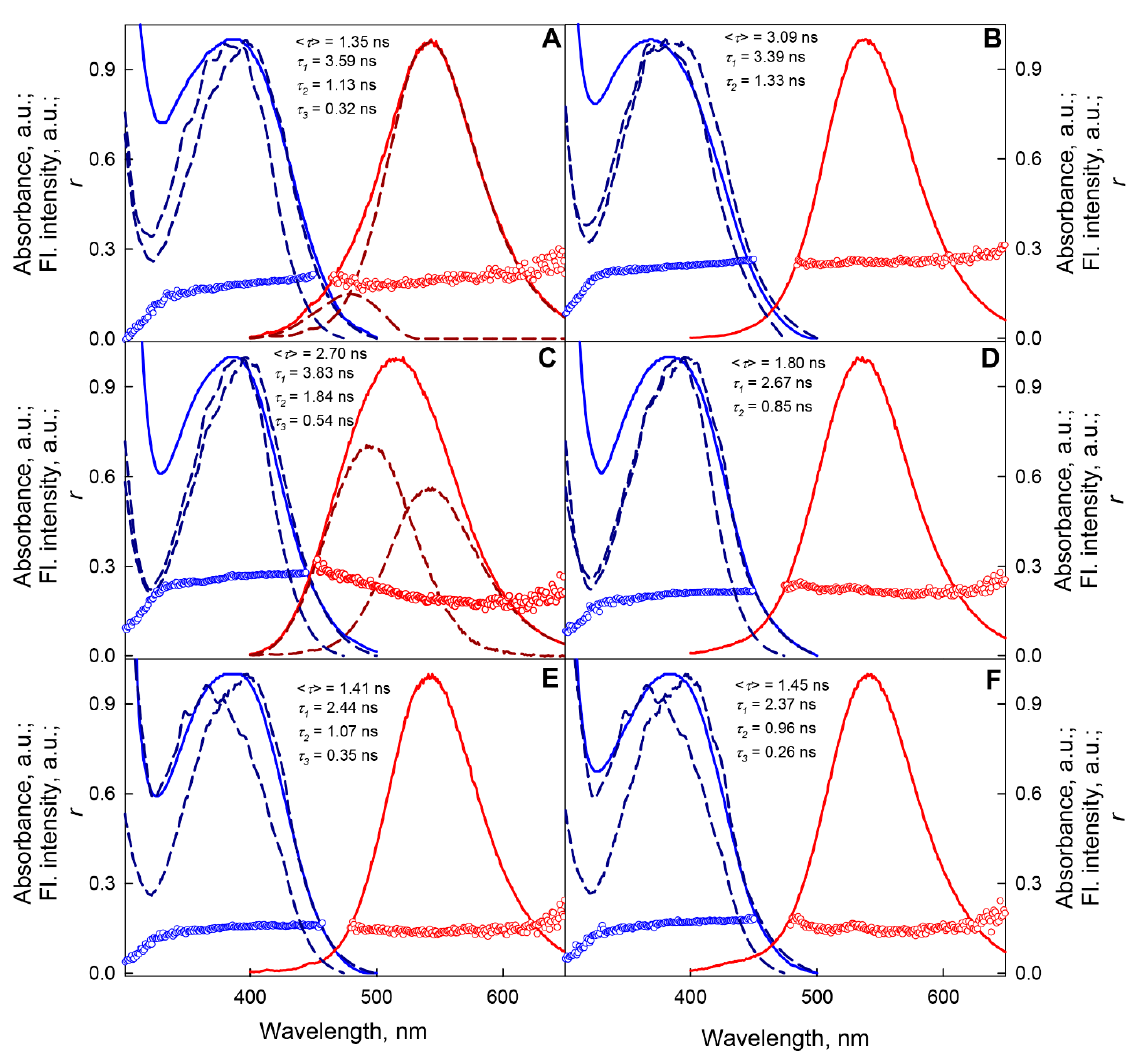
Figure 7. GdnHCl-induced changes in the spectral characteristics of BADAN linked to GGBP/H152C apo- ( left panels ) and holoform ( right panels ). The characteristics of the dye linked to the native protein. The characteristics of the dye linked to the native protein (Panels ( A , B )), partially folded state of apo-protein in 0.5 M GdnHCl (Panel ( C )), partially folded state of holo-protein in 1.5 M GdnHCl (Panel ( D )), and unfolded protein in 3M GdnHCl (Panels ( E , F ))are presented. The BADAN fluorescence spectra, components of the fluorescence spectra, and fluorescence anisotropy spectra at λ ex = 387 nm are indicated by red solid and dashed curves and red symbols, respectively. The BADAN absorption spectra, excitation spectra recorded at 475 and 530 nm, and excitation anisotropy spectra recorded at 530 nm are shown by blue solid curves and dashed curves and blue symbols, respectively.